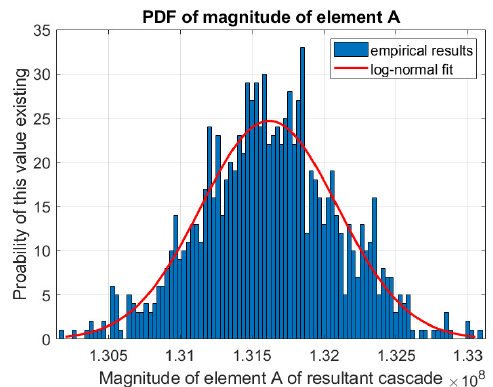
Figure 4: Sample PDF derived for the magnitude of element A of the resultant cascade, Γ , for test case A with ∆ z L = 0 : 1 mm